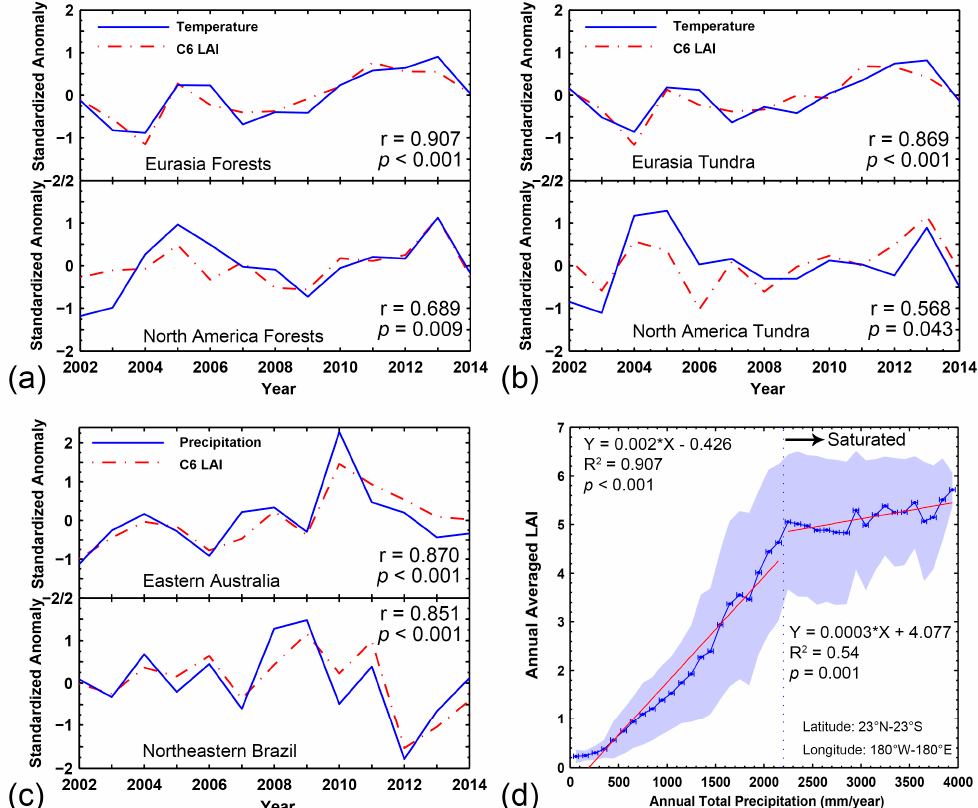
Figure 8. Evaluation of the MODIS LAI C6 product with temperature in the northern latitudes and precipitation in the ENSO-affected regions. ( a ) Temporal variations of the standardized anomalies of the growing season start period (April and May) averages of LAI and temperature for forest pixels in the northern latitudes; ( b ) same as ( a ), but for tundra pixels; ( c ) temporal variations of the standardized anomalies of annual summed LAI and precipitation in eastern Australia (20° S–40° S, 145° E–155° E) and northeastern Brazil (3° S–12° S, 35° W–45° W); ( d ) correlation between annual averaged LAI and annual total precipitation in the tropical latitudes (23° S–23° N). Standard deviations of LAIs and precipitations are denoted by blue shadow and horizontal error bars, respectively.